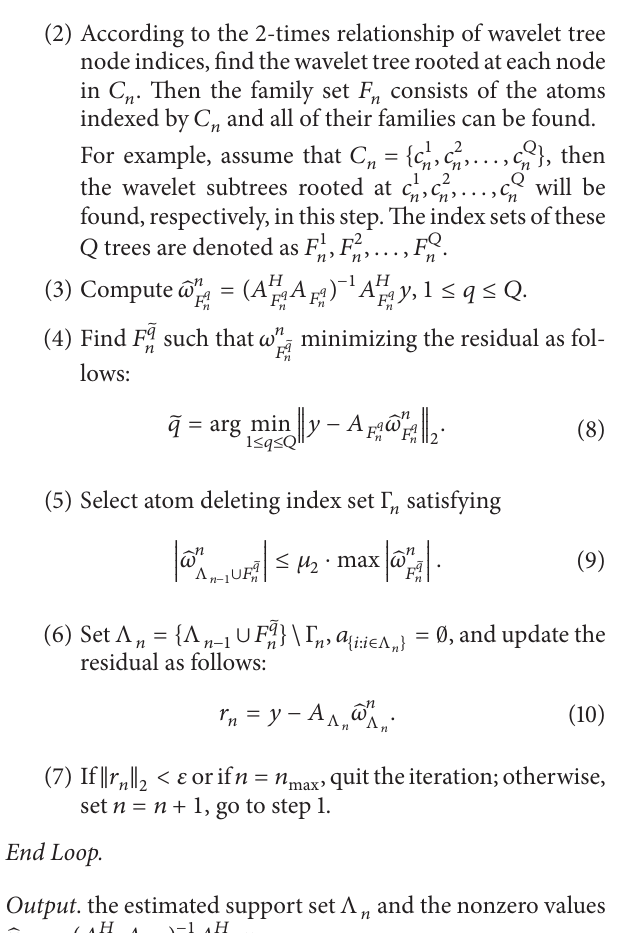
Figure 2: Wavelet tree